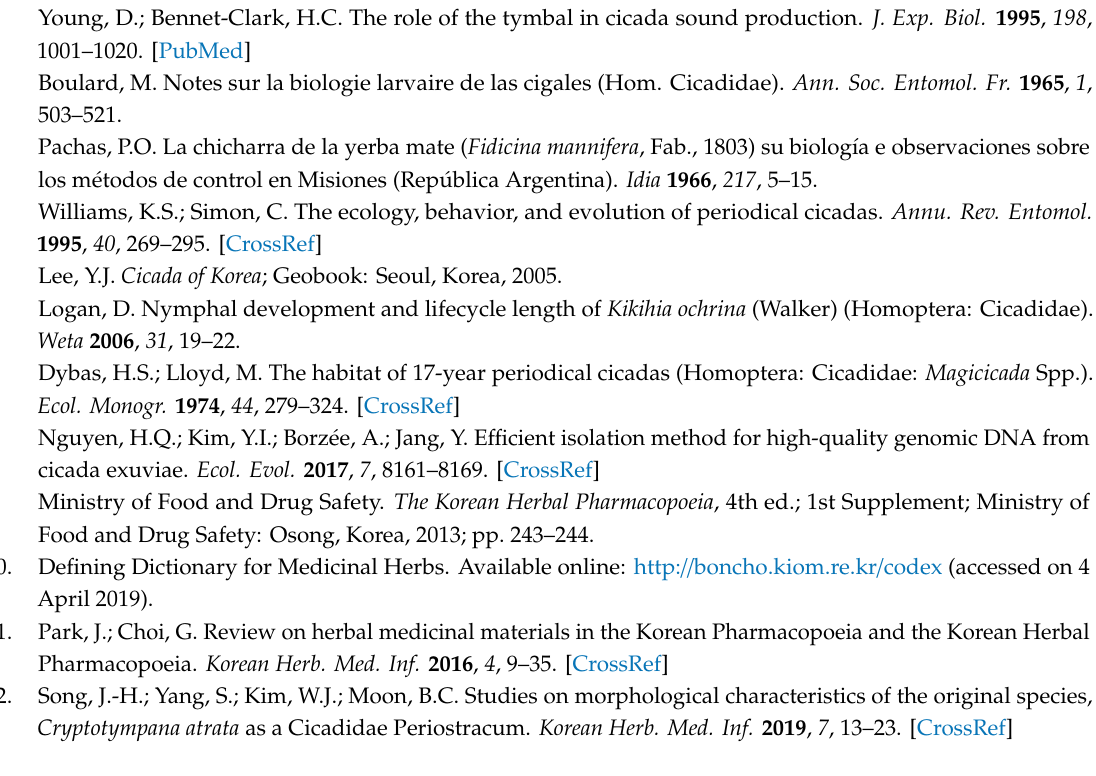
Table S1: Exuvium information of specimen, collection locality and data, with accession number for each sample in this molecular study. Asterisked accession number are sequences obtained in this